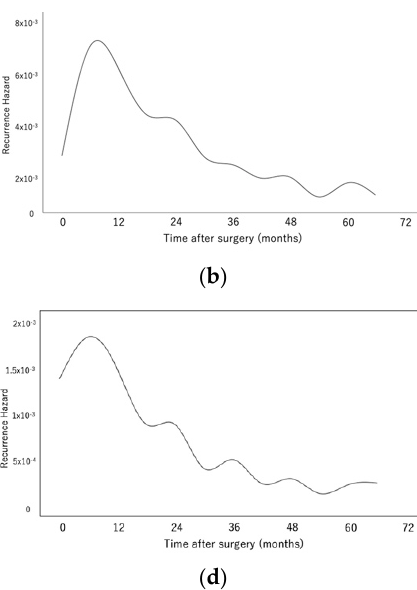
sarcoma, adenosquamous cell carcinoma, large cell neuroendocrine carcinoma, SqCC, and ADC. The approximately flat curve of carcinoid tumors lacked a distinct peak.